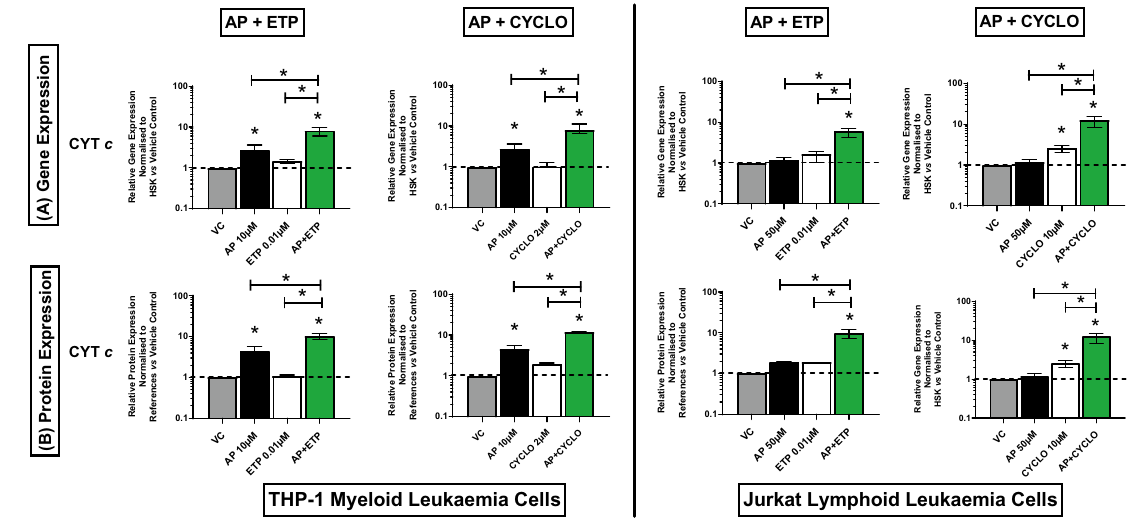
Figure 3. Effects of apigenin (AP) alone and in combination with etoposide (ETP) and cyclophosphamide (CYCLO) on expression of Cytochrome c (CYT c ) mitochondrial gene ( A ) and protein ( B ) in acute myeloid (THP-1) and lymphoid (Jurkat) leukaemia cell lines when treated with their lowest significant doses (LSDs) that induce apoptosis (determined previously in Mahbub et al., 2013, 2015, 2019) for 24 h. Gene and protein data are expressed as medians and ranges. Results were considered statistically significant when P ≤ 0.05 (*). The combination treatment effects and colours were determined based on the statistical analysis described